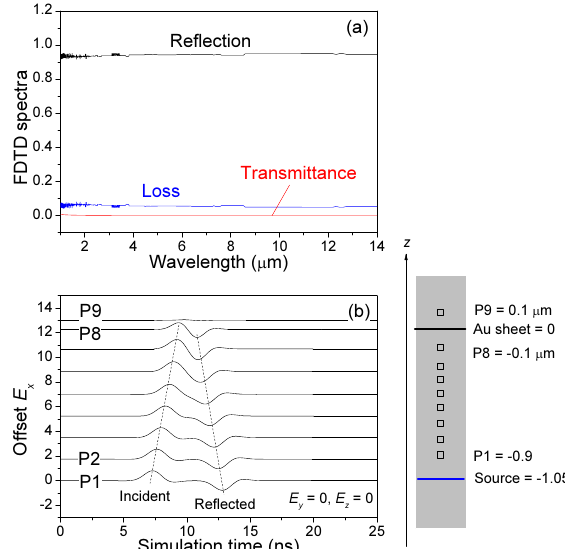
Figure 4. ( a ) Simulated reflection, transmittance, and loss of a perfect Au sheet with a thickness of 50 nm. ( b ) Temporal developments of the electric field component E x . During the whole simulation time, E y = E z = 0, at the 9 probes for initial incident ( E x , H y )